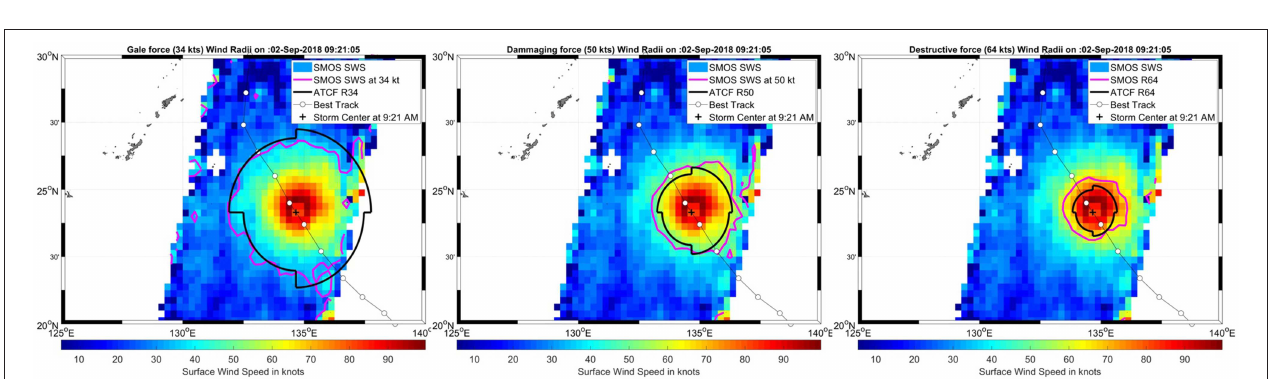
FIGURE 5 | Time series of intensity, 34-kt (gale force), 50-kt (storm force), and 64-kt (hurricane force) wind radii of Hurricane FLORENCE in September 2018. The red circles are the values from SMAP (40km spatial resolution). The green dashed line shows the Best Track (BT) estimates from the U.S. National Hurricane Center. The BT intensity values have been scaled to 10-min sustained winds ( Harper et al., 2010). The radii are shown for the NE sector.